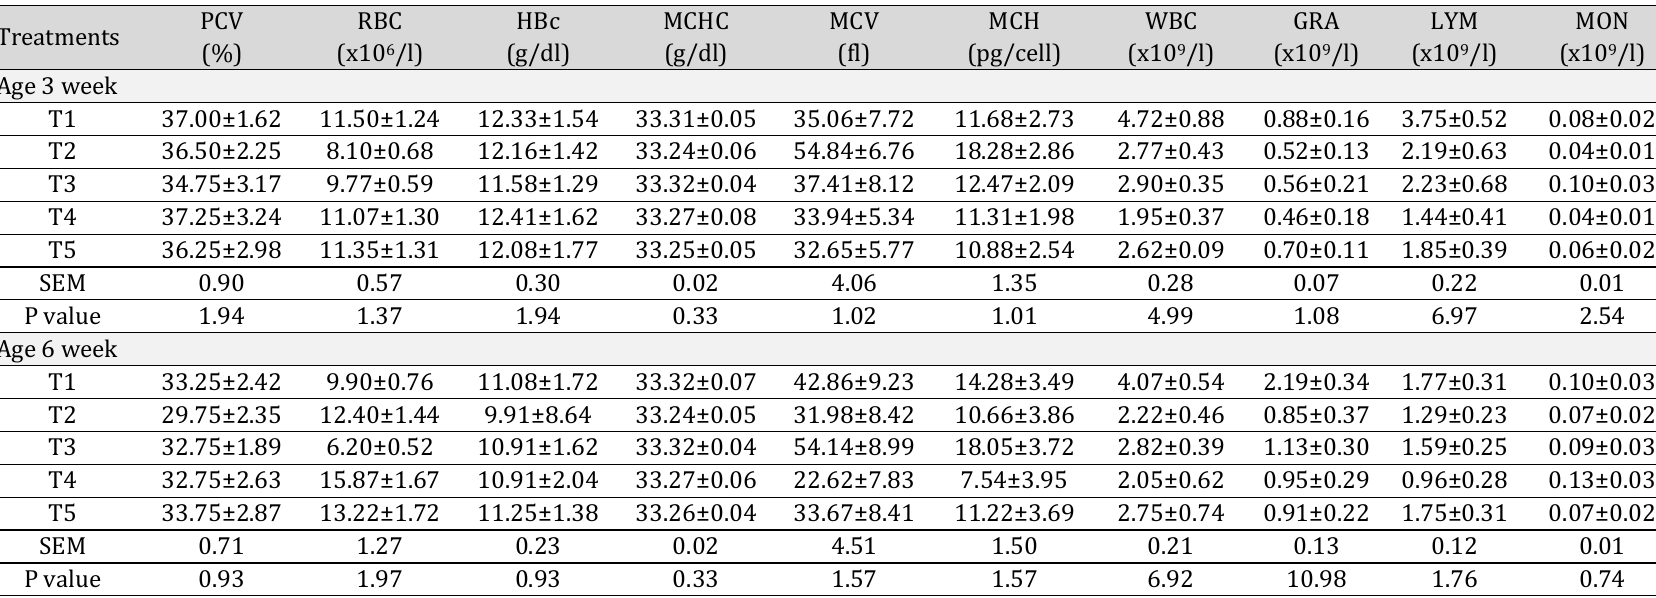
Table 3. Effect of different seed powder supplements on hematological indices of broiler chickens at 3 and 6 weeks of age.